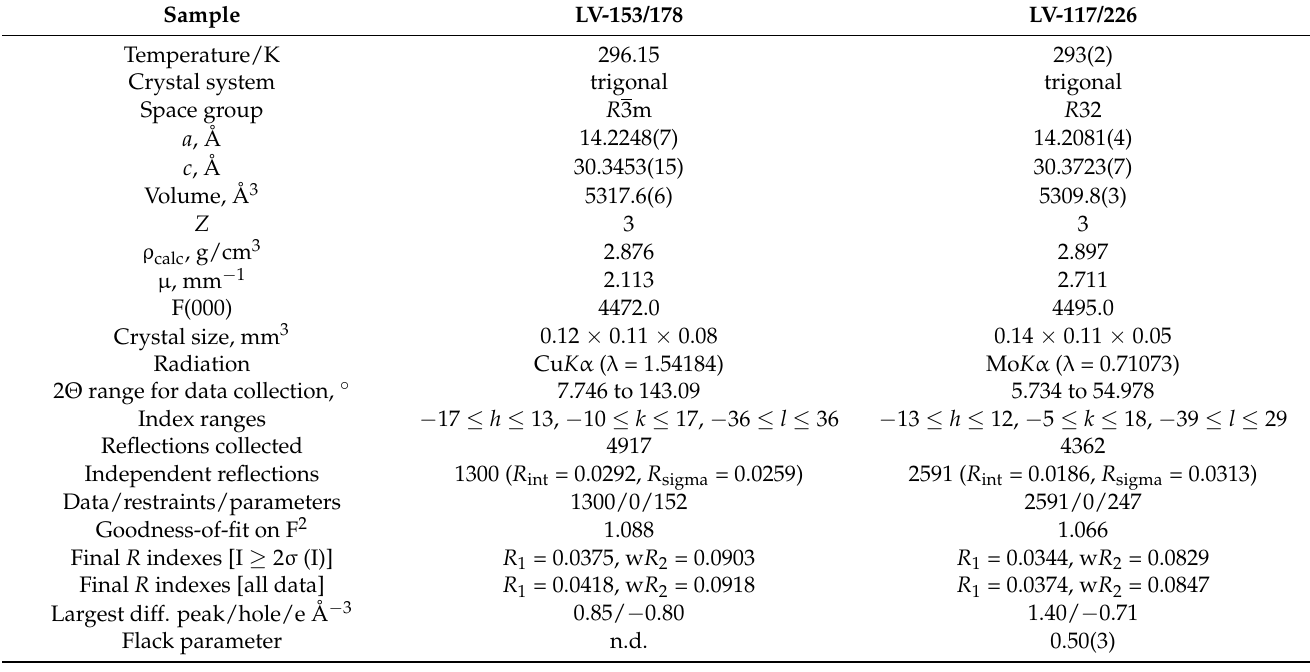
Table 2. Crystal data and structure refinement for the EGMs from samples LV-153/178 and LV-117/226.